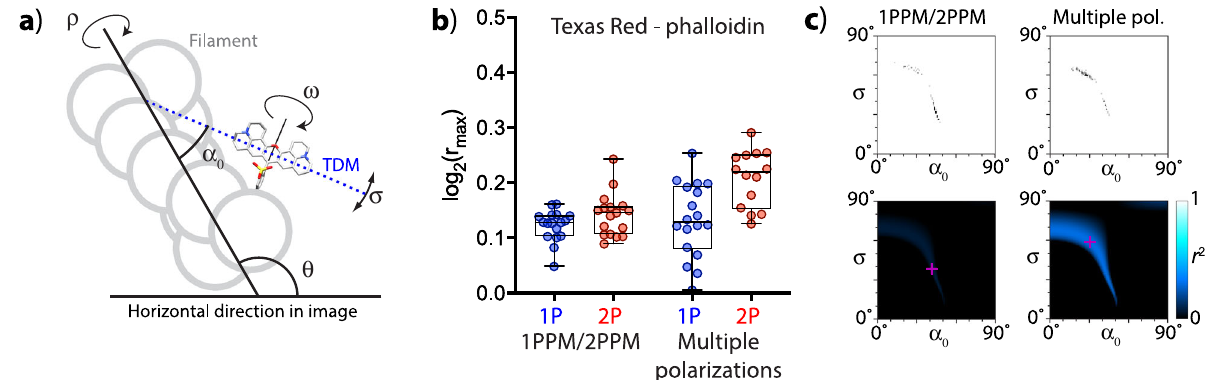
Fig. 9 Quantitative polarization microscopy imaging of cellular micro fi laments stained with Texas Red-phalloidin. a Model of a fi lamentous structure allowing describing molecular orientations by a Gaussian distribution characterized by a mean tilt angle α 0 and distribution width σ . Rotational symmetry along the fi lament axis (angle ρ ) is taken into account. In contrast, rotation along a dye-attachment axis (angle ω ) would prevent meaningful application of the Gaussian distribution model of molecular tilt angles. b Quantitation of LD observed by 1PPM/2PPM, and with multiple polarizations of excitation light. c Plots showing combinations of α 0 , σ consistent with our 1PPM/2PPM and multiple-excitation polarization observations (top: con fi dence intervals obtained by bootstrapping analysis, bottom: coef fi cients of determination r 2